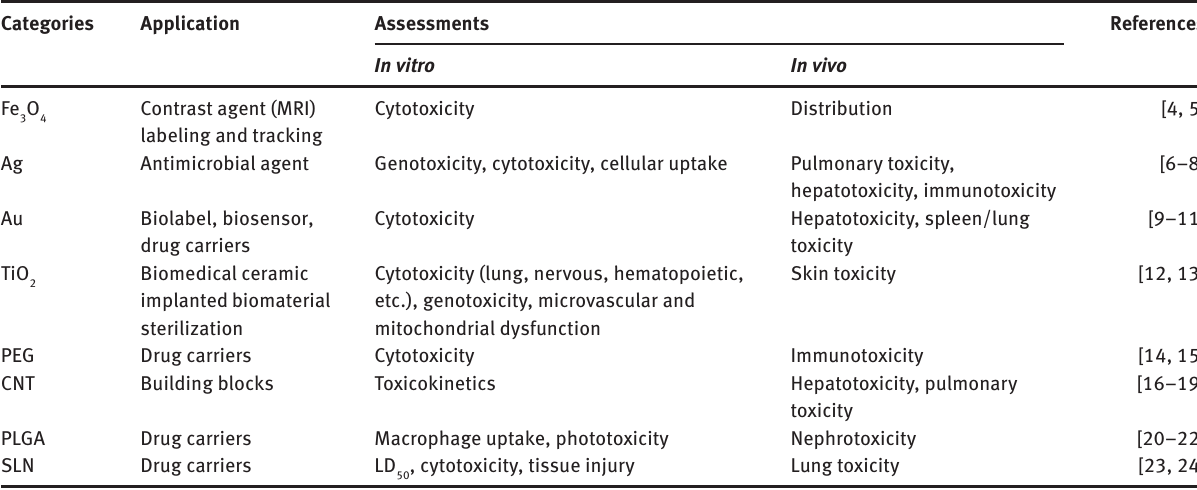
Table 1: Assessments of some NPs in medical